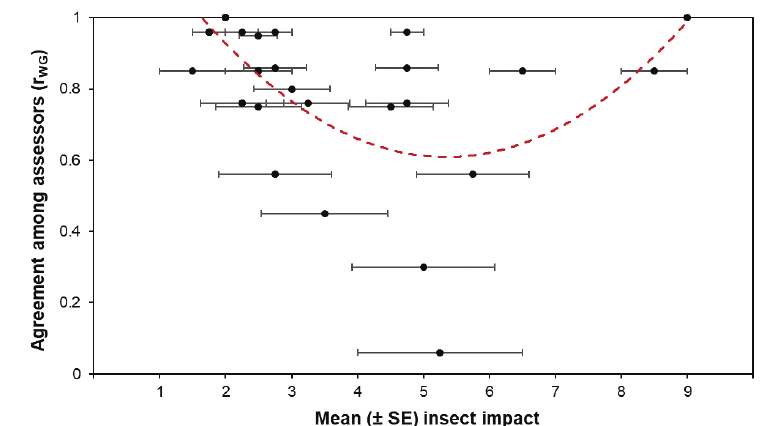
Figure 4. Within-group inter-rater agreement ( r ) values (0–1, with 0 indicating no agreement and 1 WG indicating perfect agreement) for each mean ( ± SE) insect impact (1–9, with 1 indicating low impact and 9 indicating high impact insect species) with a trendline shown in red.